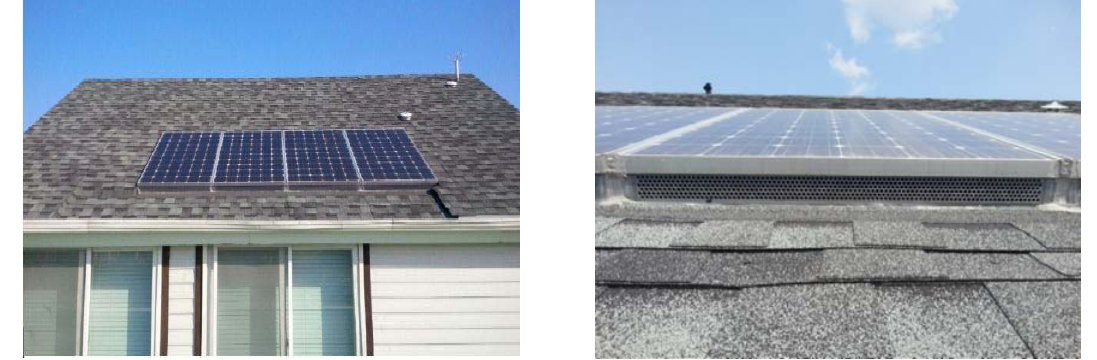
Figure 5. Experimental house with roof ‐ integrated air ‐ type PVT collectors.